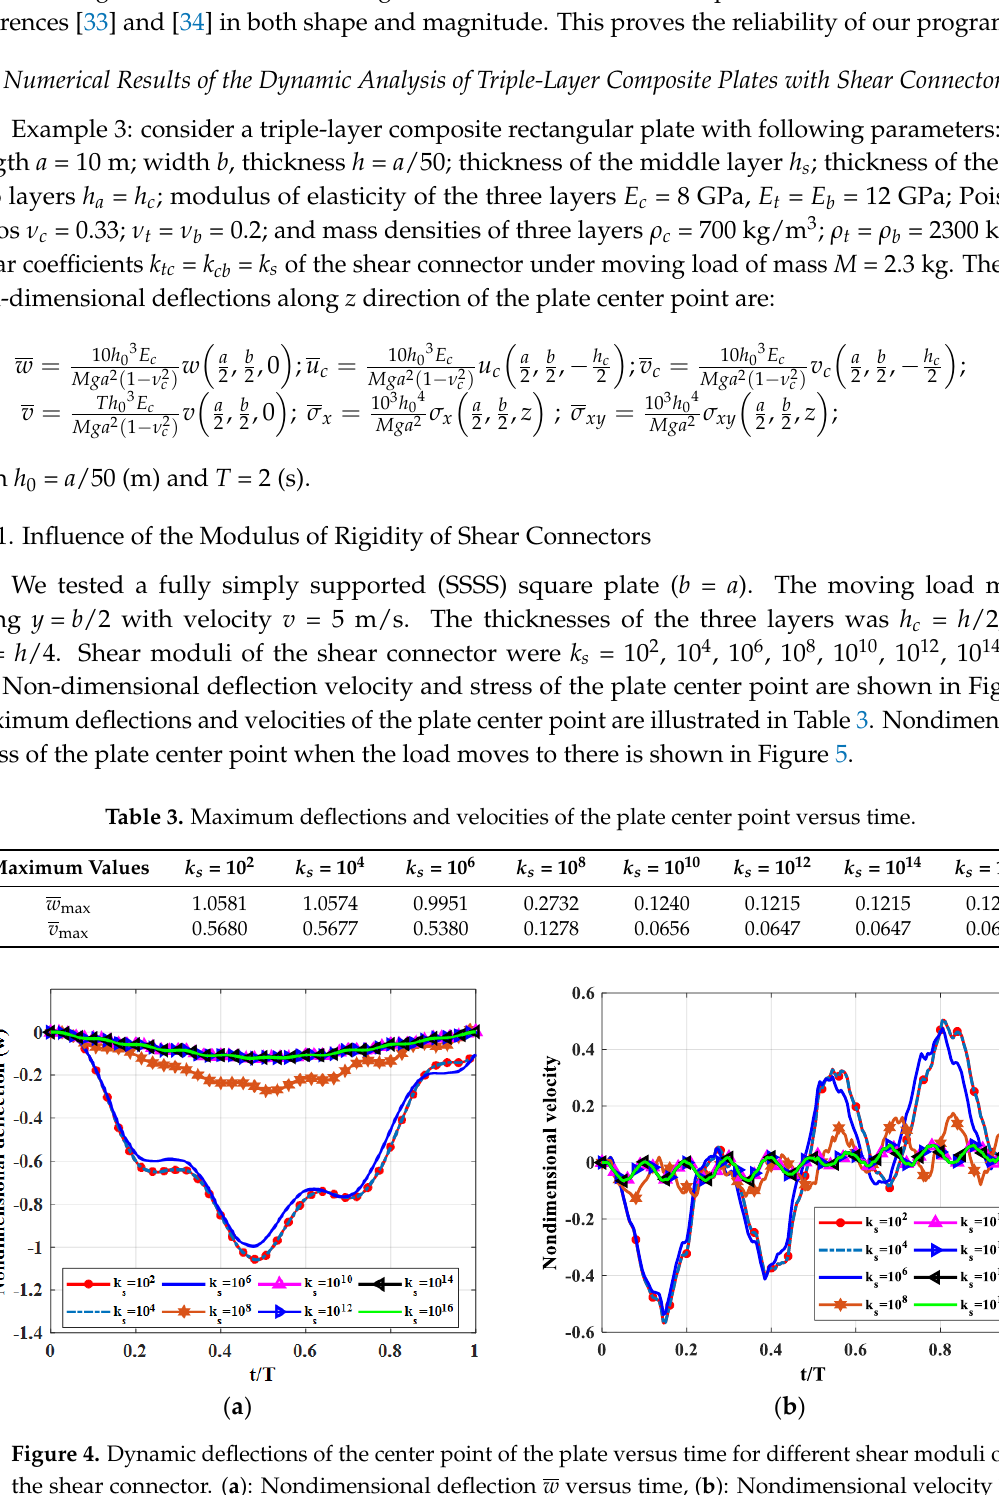
( b ) Figure 5. Non-dimensional stress of the plate center point when the load moves to the plate center point. ( a ): Nondimensional stress x  versus thickness, ( b ): Nondimensional stress xy  versus thickness. From Figure 4 and Table 3, we can conclude that when the shear modulus of the shear connector is increased from 10 2 to 10 14 Pa, the deflection and velocity of the plate center point, and the stress of the center point of the structure as a function of thickness in z-direction, decreased and decreased significantly at k s = 10 10 Pa (above 10 10 Pa, the deflection was nearly constant). With k s in the interval (10 2 – 10 6 ), the deflection reached its maximum. We can easily see the stress jumping at the contact surfaces in Figure 5. When k s was small, the stress jumping was high. Therefore, depending on different cases in practice, we can choose correspondingly the suitable shear modulus for reducing the vibration of the plate. 4.2.2. Influence of the Ratio h c / h t In the following experiment, we tested a fully simply supported (SSSS) square plate ( b = a ). The shear modulus of the shear connector was k s = 50 MPa. The moving load travelled along y = b /2, with velocity v = 5 m/s, h c /h t = 1, 2, 4, 6, 8, 10, 12, 14 considered (the plate thickness h = h b + h c + h t was fixed). Non-dimensional deflection and the velocity of the plate center point are shown in Figure 6. Maximum deflections and velocities of the plate center point are illustrated in Table 4.